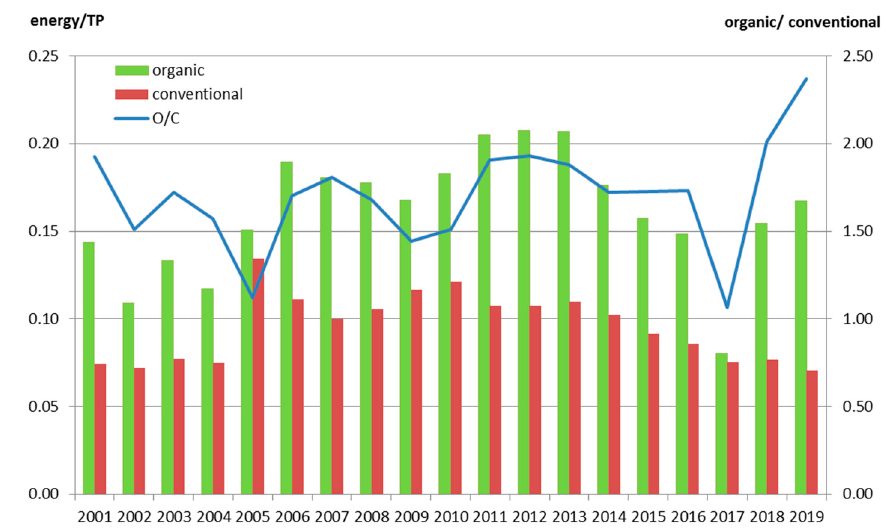
Figure 7. Energy consumption per unit of total product (TP). (Source: [38], authors’ elaboration). Note: Both energy consumption and total production are expressed in EUR.